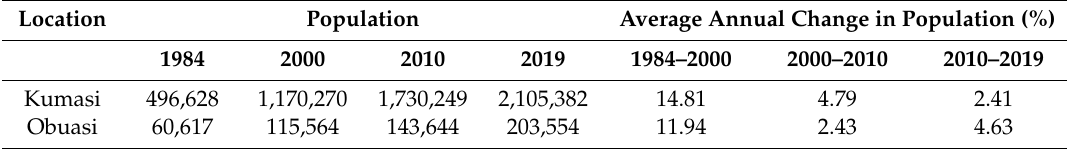
Table 3. Population statistics for Kumasi and Obuasi